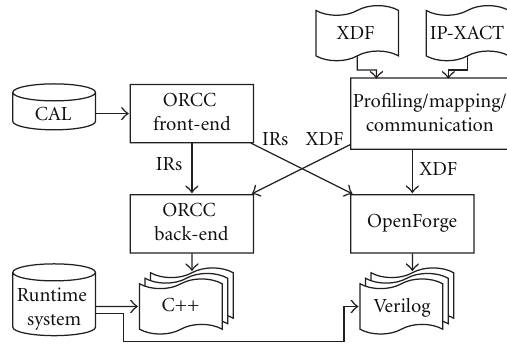
Figure 2: The cosynthesis tool